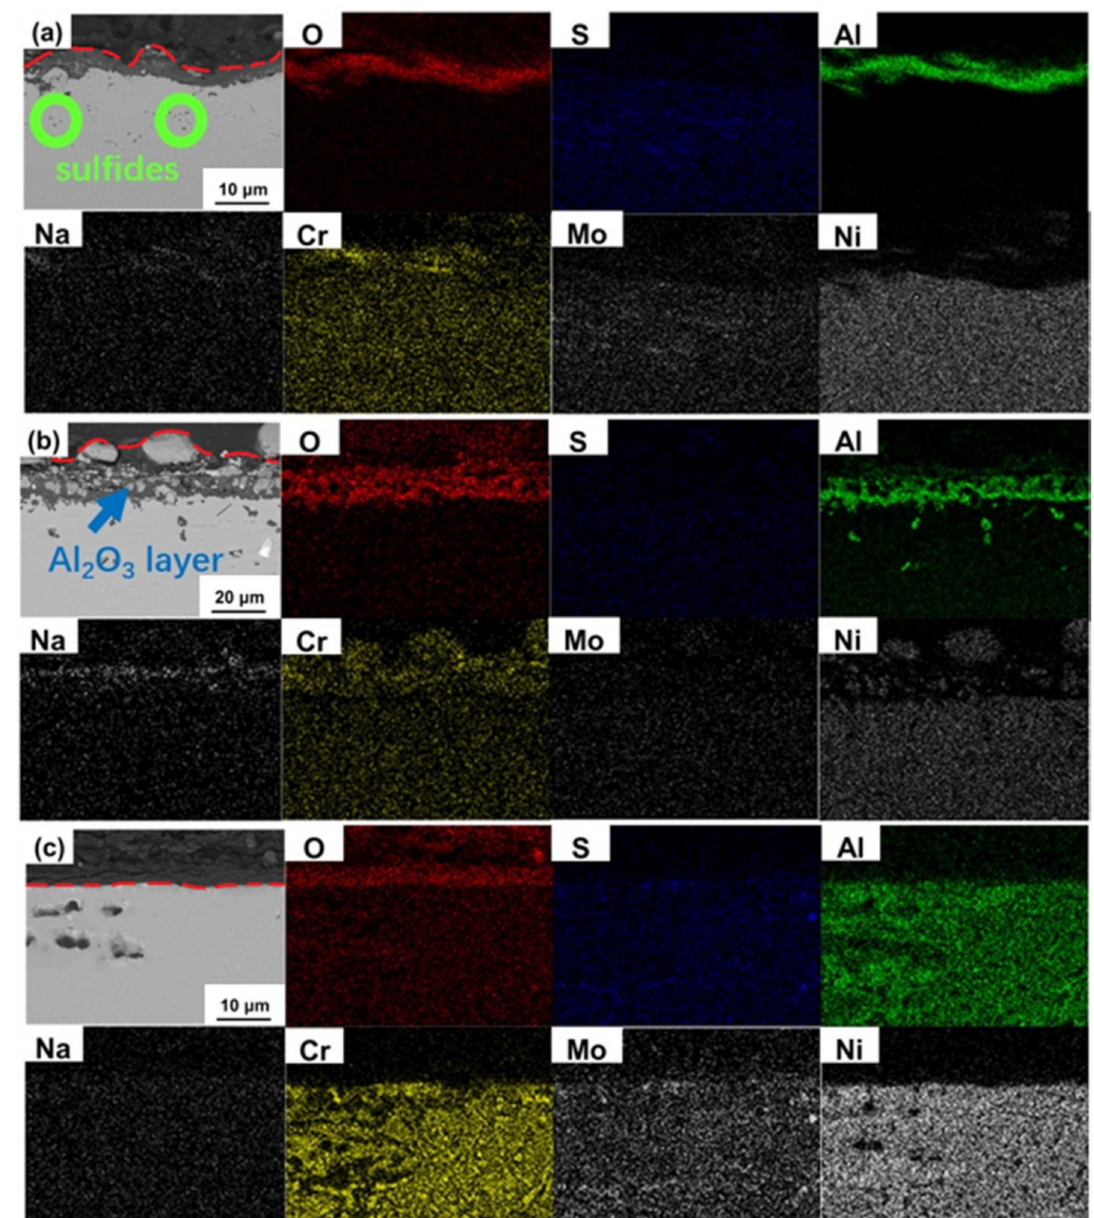
Figure 7. The cross-section morphologies and energy dispersive spectrometer (EDS) images of the sealed corroded samples at 900 ◦ C for 200 h: ( a ) Alloy 1, ( b ) Alloy 2 and ( c ) Alloy